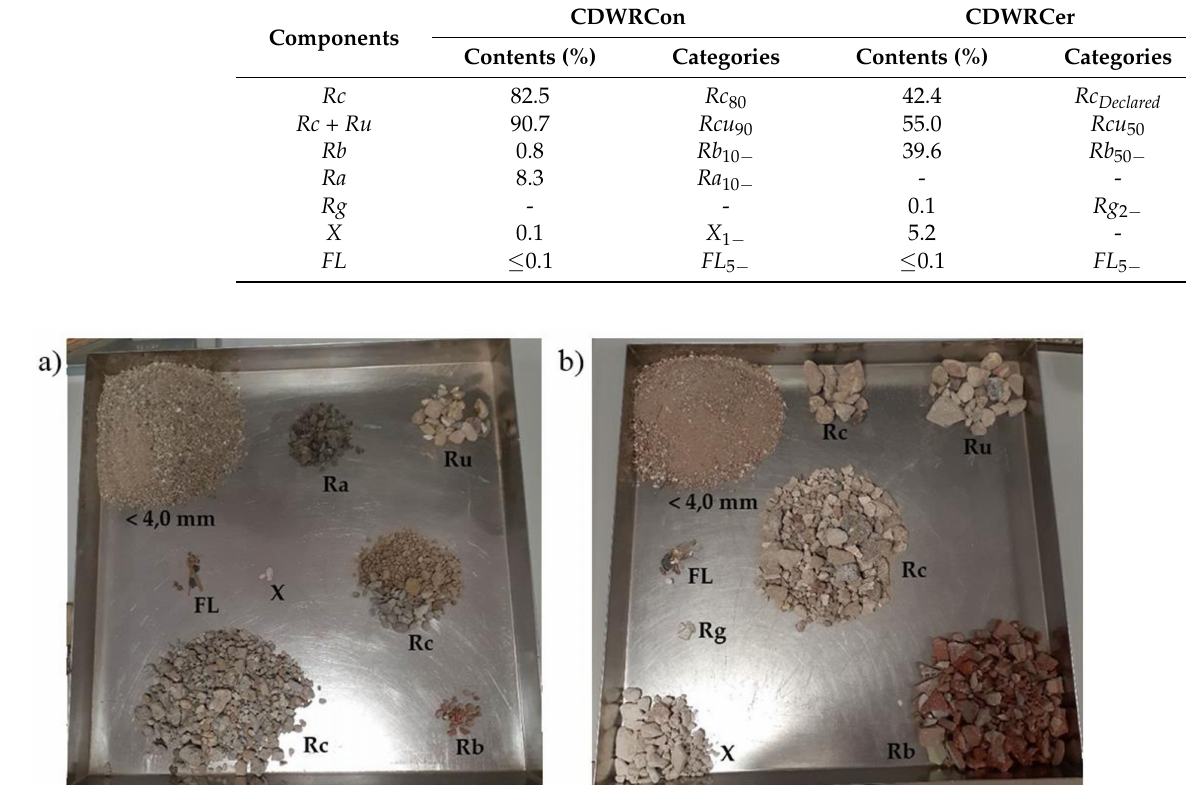
Figure 1. Visual appearance of the aggregates: ( a ) CDWRCon and ( b ) CDWRCer components.